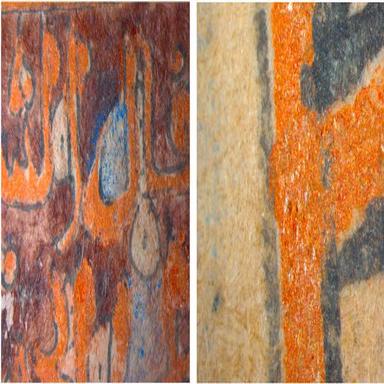
Mss 19 was the only one where an orange paint was found. It is not based in red lead as common in the European production, but prepared admixing vermilion with orpiment (a common combination in Islamic manuscripts). It was used in the full-page illuminations of fol.110r (left) and fol.218v (right).